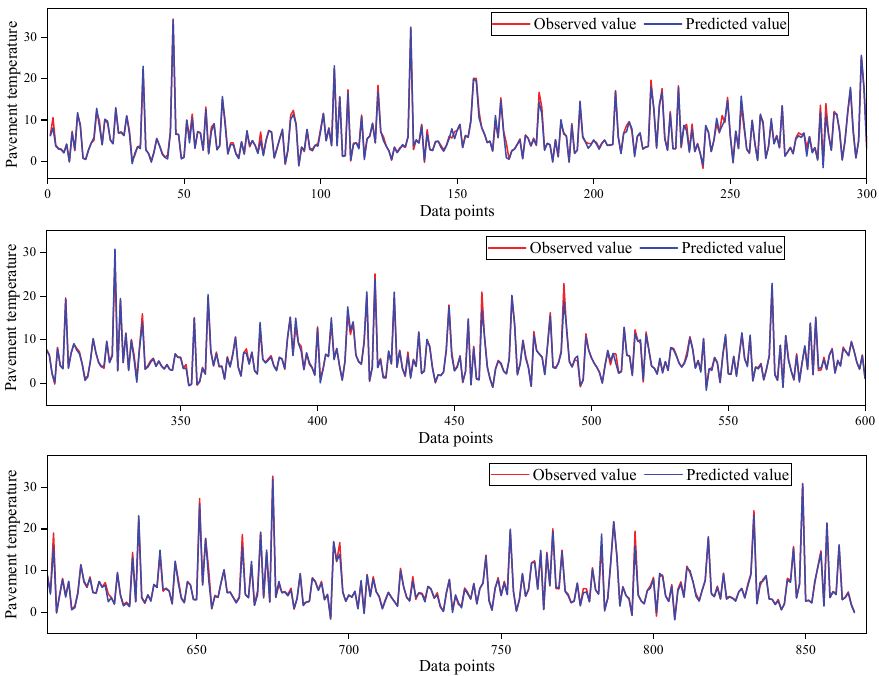
Figure 12. Comparison of pavement temperature truth and predicted values in the test set. Data points 1 ‐ 300 in the test set ( first ), Data points 301 ‐ 600 in the test set ( second ), Data points 601 ‐ 866 points 1–300 in the test set ( first ), Data points 301–600 in the test set ( second ), Data points 601–866 in in the test set ( third ) the test set ( third